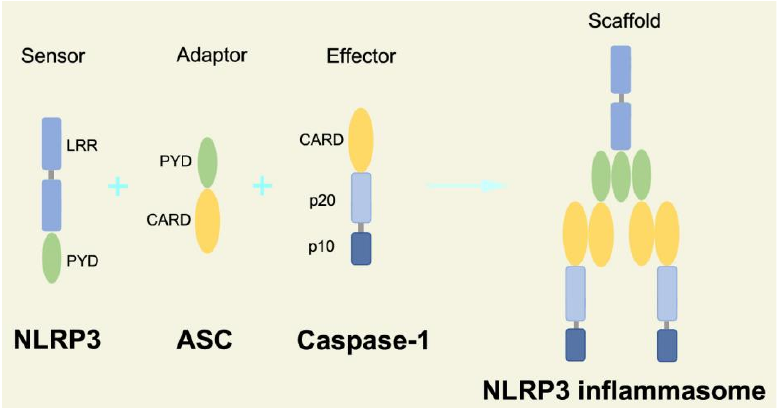
Figure 2. Structure and assembly of NLRP3 inflammasome. NLRP3 inflammasome consists of NLRP3, ASC, and caspase-1, which are known as sensor, adaptor, and effector, respectively. In the canonical pathway of pyroptosis, when cytosolic pathogen recognition receptors (PRRs), NLRP1b, NLRP3, NLRC4, AIM2, or Pyrin are stimulated by the